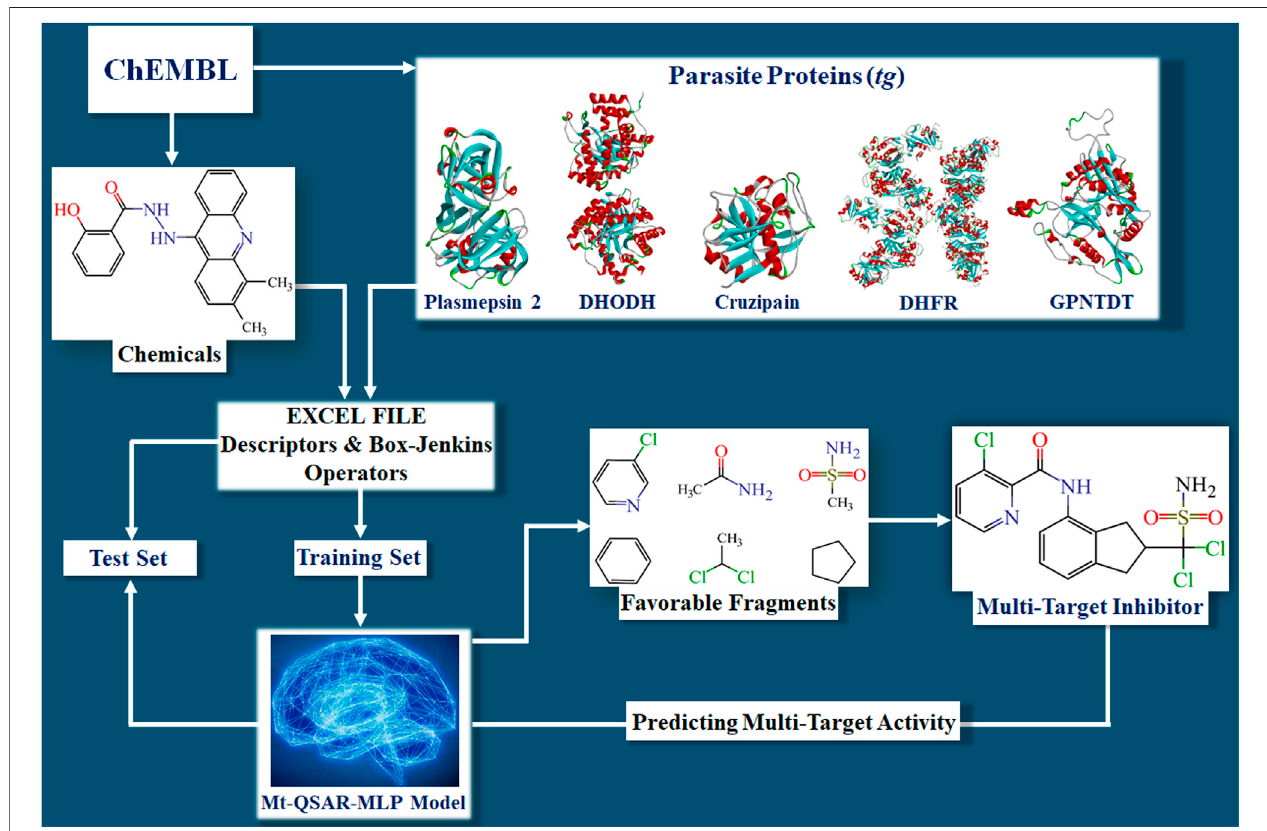
FIGURE 1 | Steps involved in the construction ofthe mt-QSAR-MLP model. The abbreviations DHODH, DHFR, and GPNTDT refer to the parasite proteins named dihydroorotate dehydrogenase, dihydrofolate reductase, and glycylpeptide N-tetradecanoyltransferase, respectively.